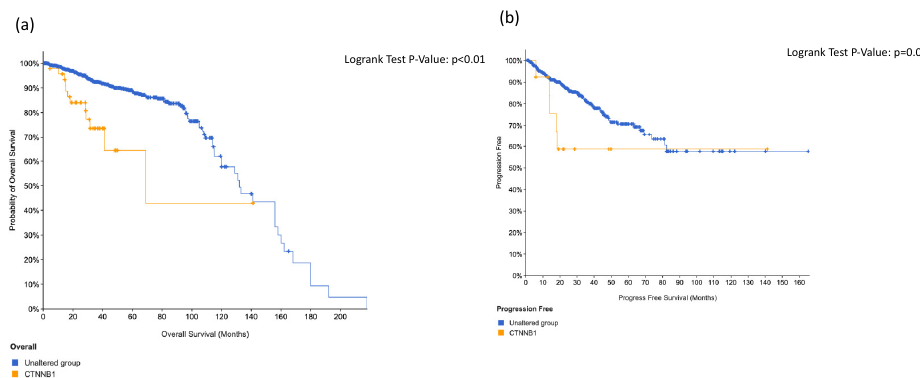
Figure 7. Overall survival ( a ) and disease-free survival ( b ) in CTNNB1-positive prostate cancer pa-